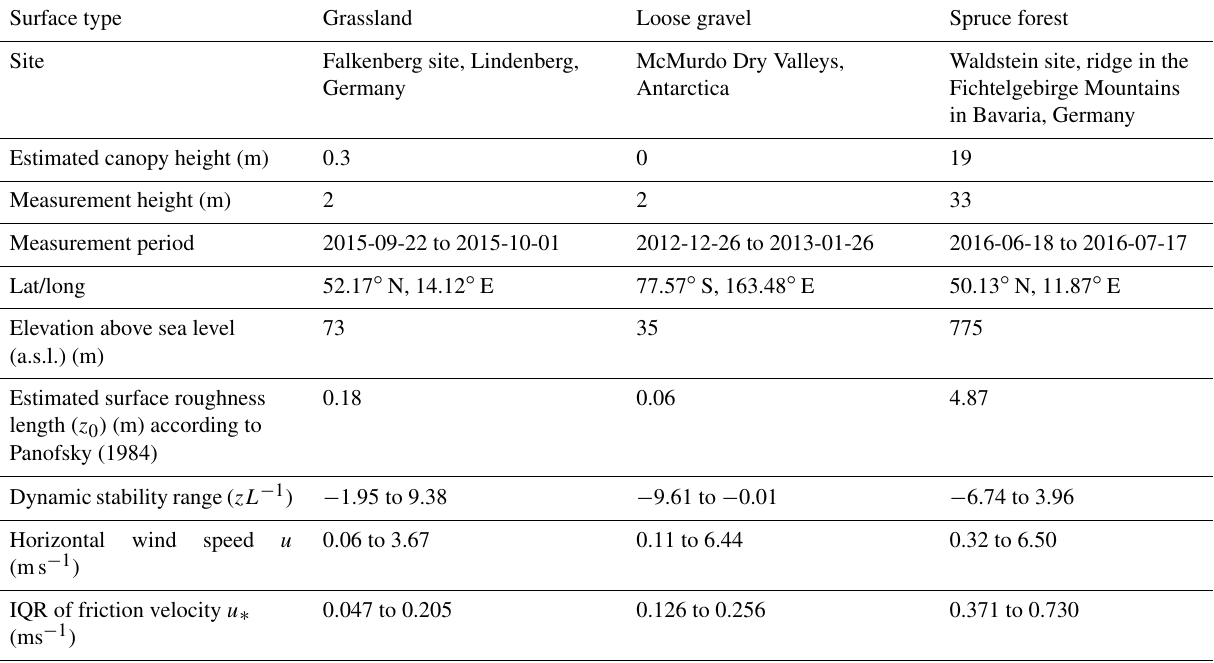
Table 1. Description of the three data sets used in this study: numbers from quality-screened data, aggregated to 30min temporal resolution. IQR signifies interquartile